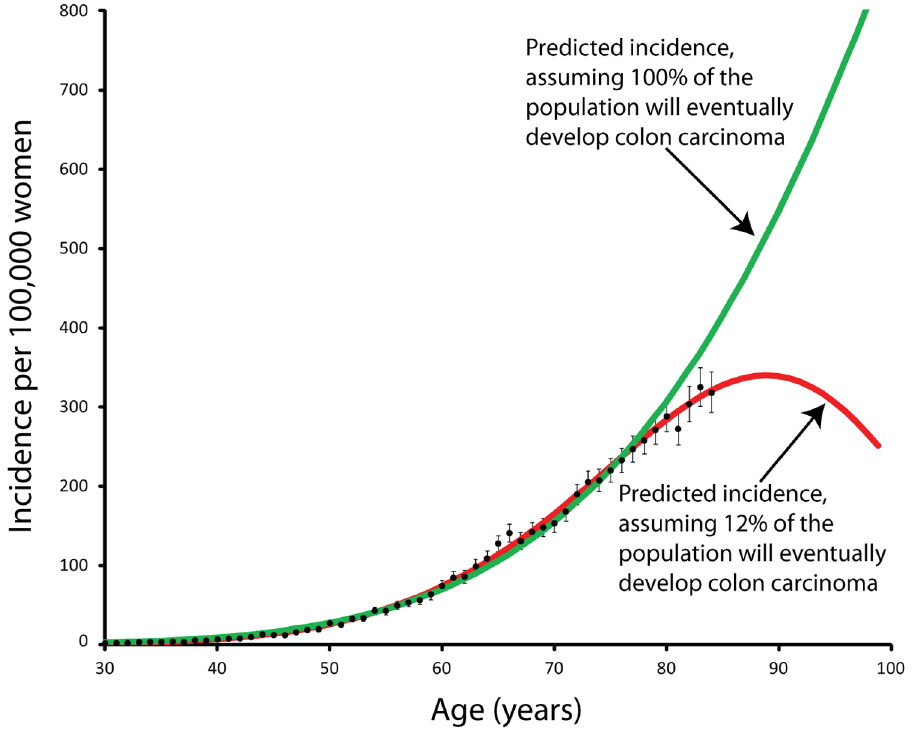
Figure 3. This figure presents the incidence of colon cancer during the year 2000 as measured by the SEER-17 cancer registries. Two fitted Weibull distributions are shown. The first assumes that 100% of the population will eventually develop colon carcinoma, while the second makes no assumption about the fraction of the population that will develop colon carcinoma, but instead fits it as a parameter. The best fit parameter is about 12% of the population, while the line representing 100% of the population is a good fit, but not perfect. More data in the 85–99 range will clearly delineate between the two cases.